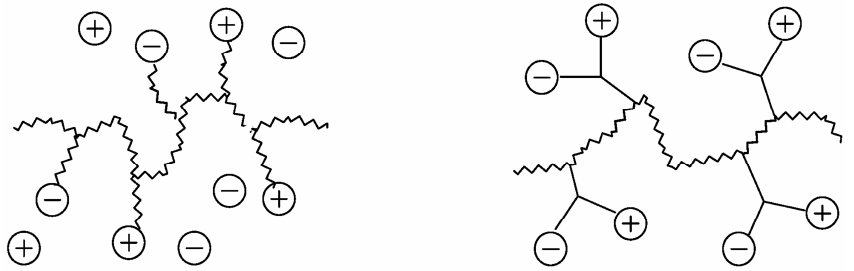
Figure 1. Polyampholyte ( left ) bearing both negative and positive charges statistically distributed along the polymer backbone, and ( right ) polyzwitterion, bearing both charges in every repeating unit. Reprinted from [101].